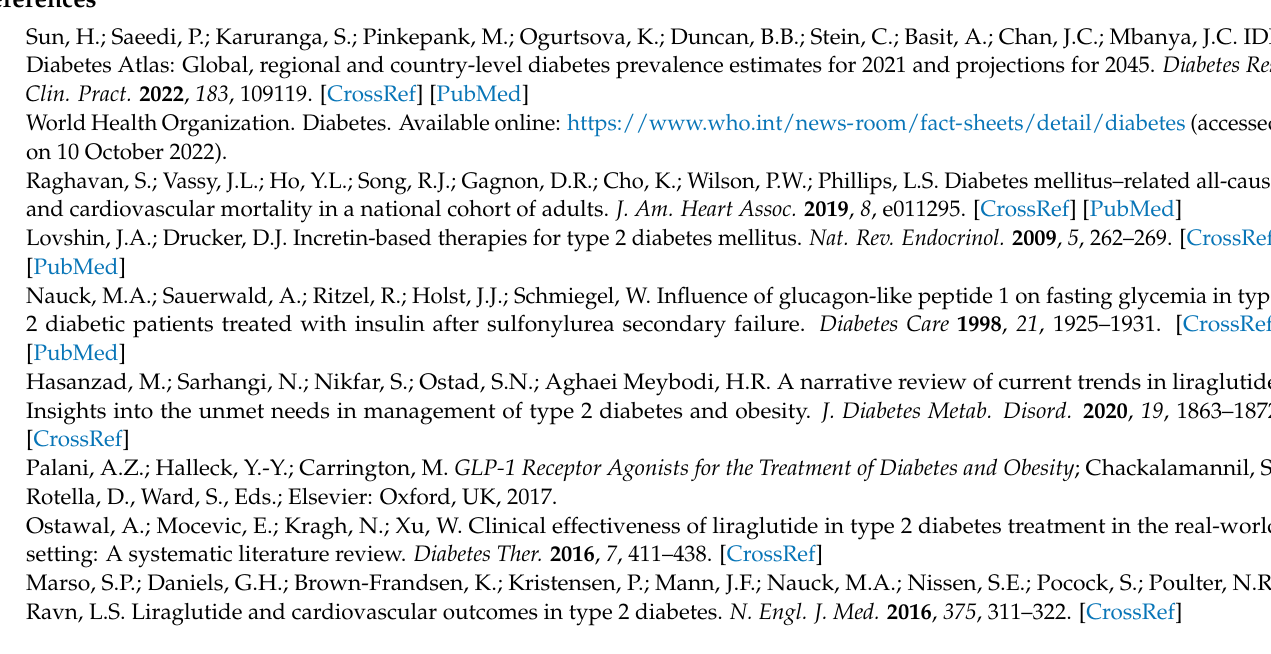
Figure S2: Reference gel with 58 statistically significant spots between the pre-treatment and post-treatment samples (ANOVA, p ≤ 0.05; fold-change ≥ 1.5). Table S1: Experimental design; Table S2: Mass spectrometry list of significant differentially abundant proteins; Table S3: Different canonical pathways obtained from STRING database